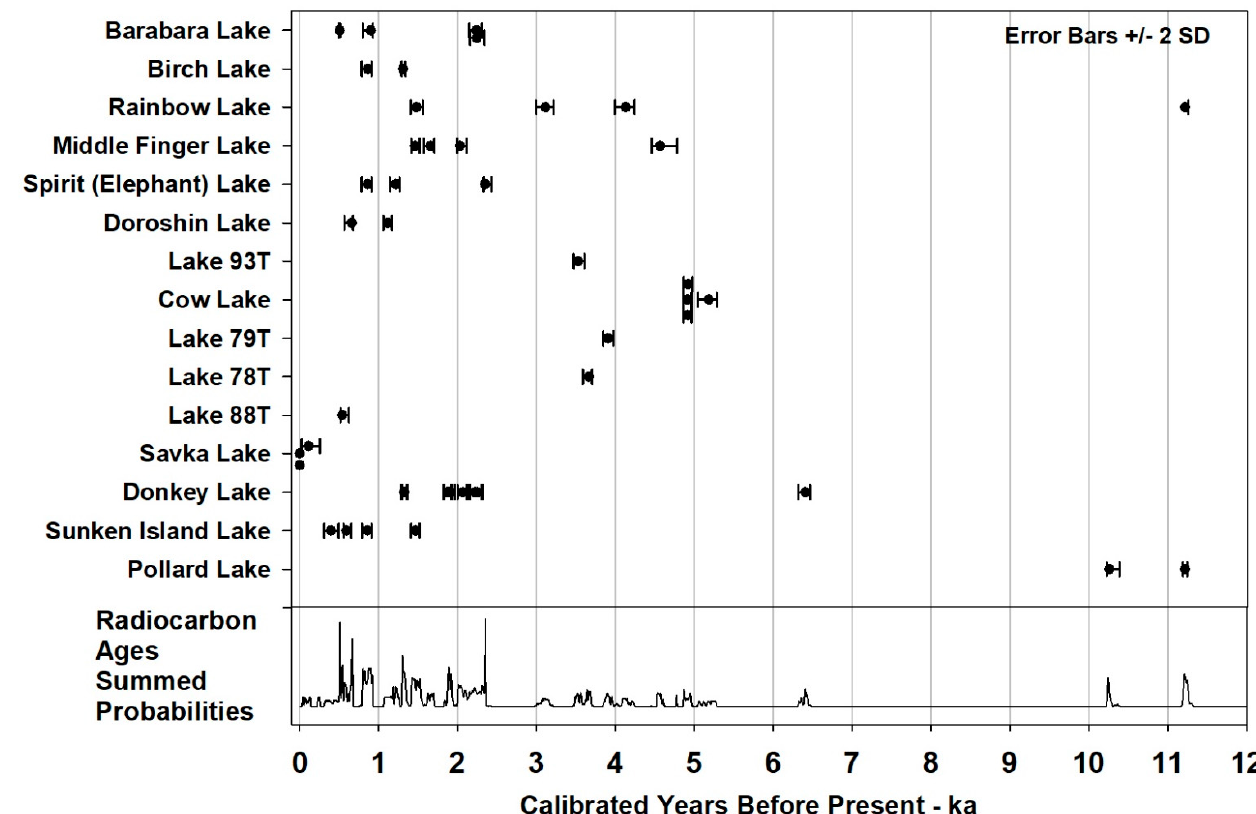
Figure 5. Ice-shoved rampart chronology ( n = 15 lakes). Radiocarbon ages are for various organic materials excavated from the ISRs. All lakes are closed − basin except Pollard Lake. Summed proba- bilities do not include multiple samples from the same ice-shove event, e.g., Cow Lake. The sample and probability distributions are biased, because (1) only the most landward (oldest) berms were sampled; sampling the younger berms would add more younger dates. (2) Older berms have likely been lost as water levels rose and wave action reworked them.